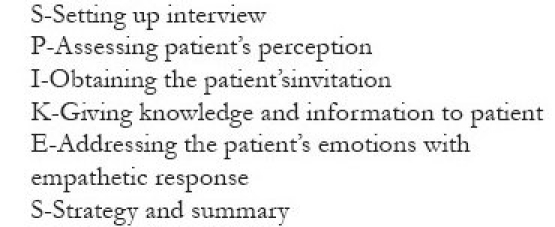
Spikes protocol